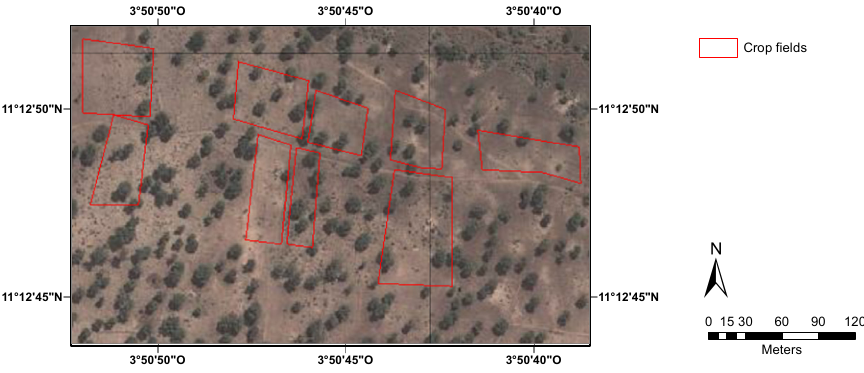
Figure 9. Intra-plot variability in the Burkina Faso site. In situ data plots are overlayed in red. The fields are highly heterogeneous and difficult to classify as a single crop. c (cid:13) 2015 Google Imagery, c (cid:13) 2015 DigitalGlobe.